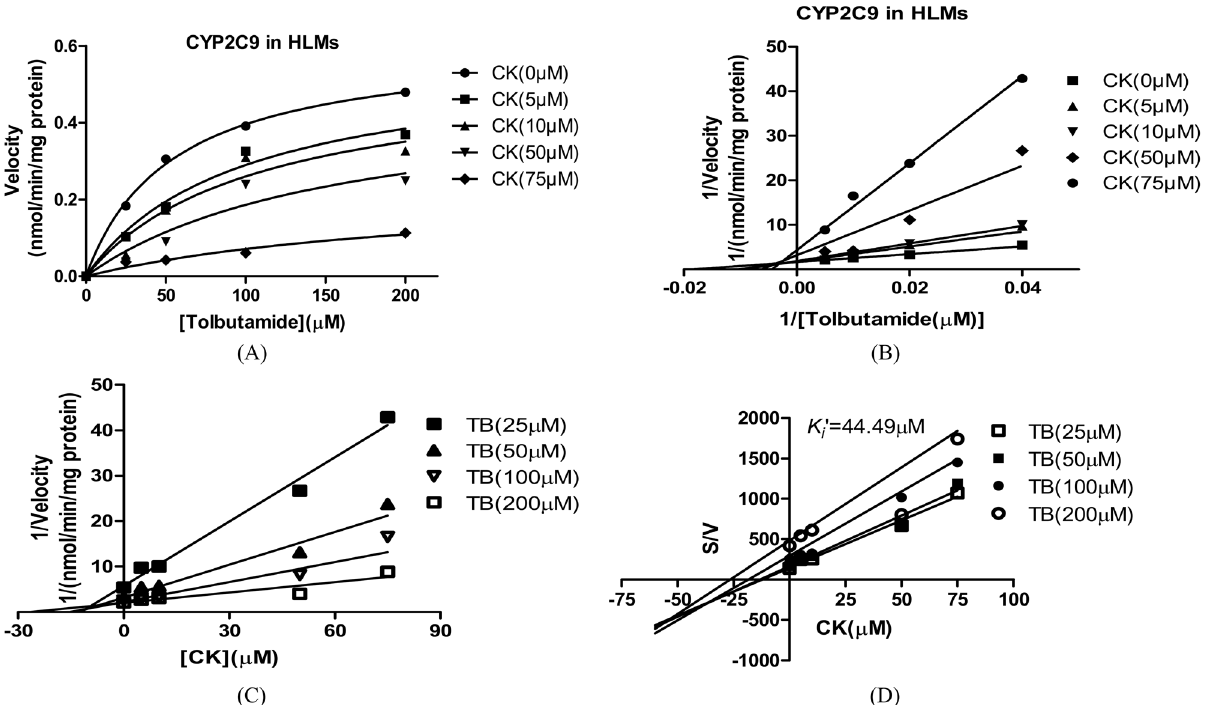
Fig 6. A nonlinear regression analysis curves of velocity (nmol/min/mg protein) enzyme activity for tolbutamide ( μ M) assuming Michaelis-Menten kinetics (A), representative Lineweaver-Burk plots (B) and Dixon plots (C) of the effect of CK on tolbutamide 4-hydroxylation formation and S/V versus [I] plots (D)in human liver microsomes, Note: The inhibition of CYP2C9 activity is best described as a mixed type inhibition mechanism by different concentrations of CK (10 – 100 μ M) in HLM incubations (0.5 mg (cid:3) mL -1 protein). The data points are the mean values of triplicate incubations. TB, tolbutamide.